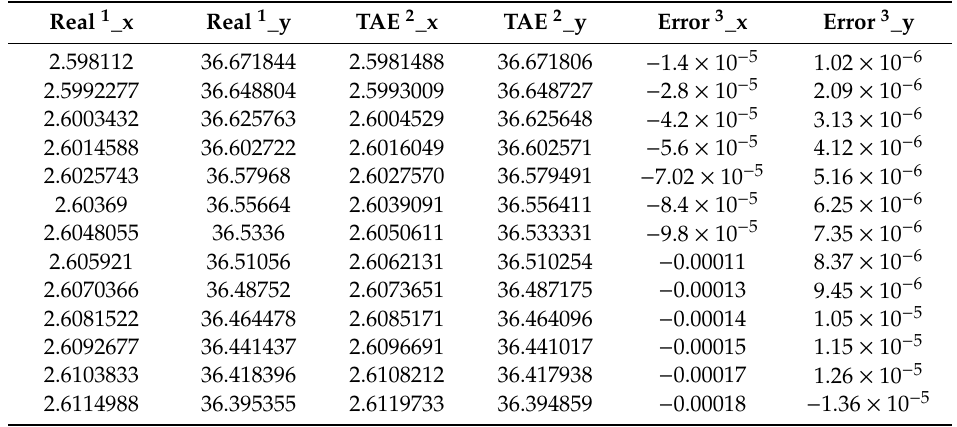
Figure 11. Experiment on creating a return path using the return path algorithm in an actual curling field.